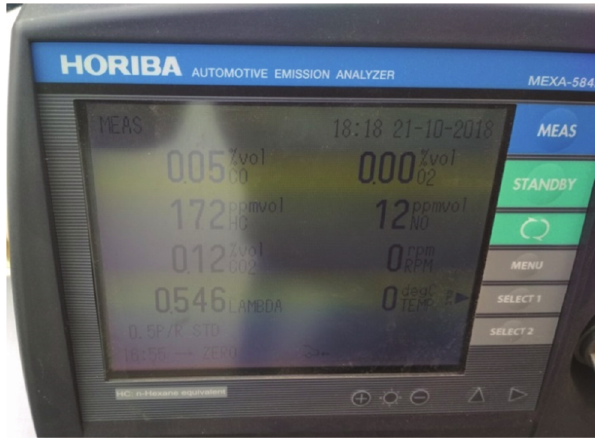
Fig. 8. Test stand – Horiba apparatus display (after switching off the engine)